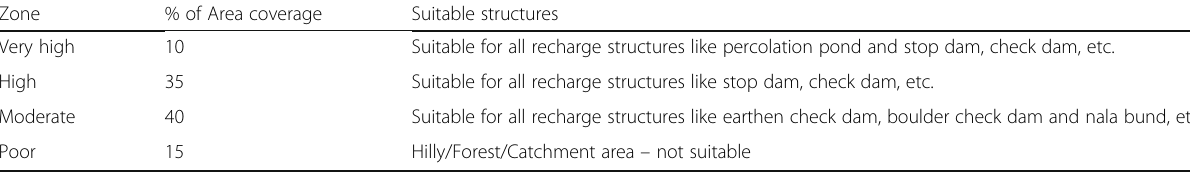
Table 2 Resultant output showing percentage of zone wise area of coverage Zone % of Area